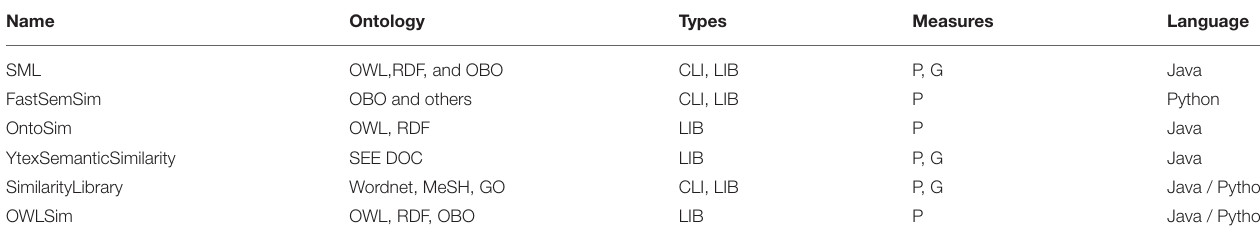
TABLE 2 | Semantic tools and ontology design for CLI and